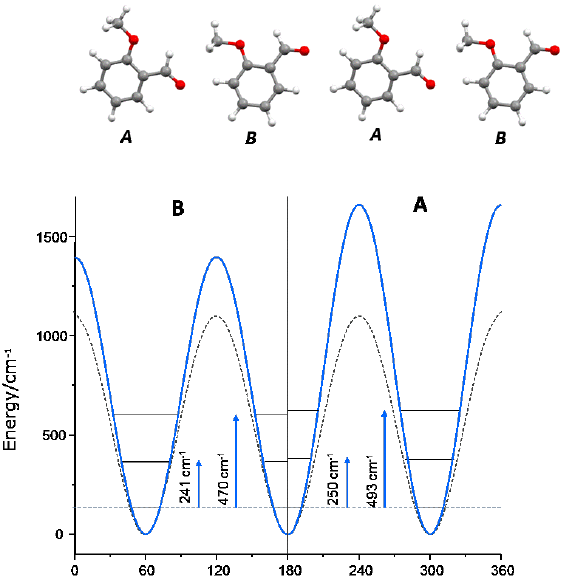
Figure 8. Top: sequence of A–B–A–B type molecules in the crystal structure of 2MeOB, evidencing the different methyl group neighboring. Bottom: potential energy function for ( B ) a ( A ) molecules derived from observed torsional frequencies (solid lines) and calculated for the isolated molecule (dashed line).